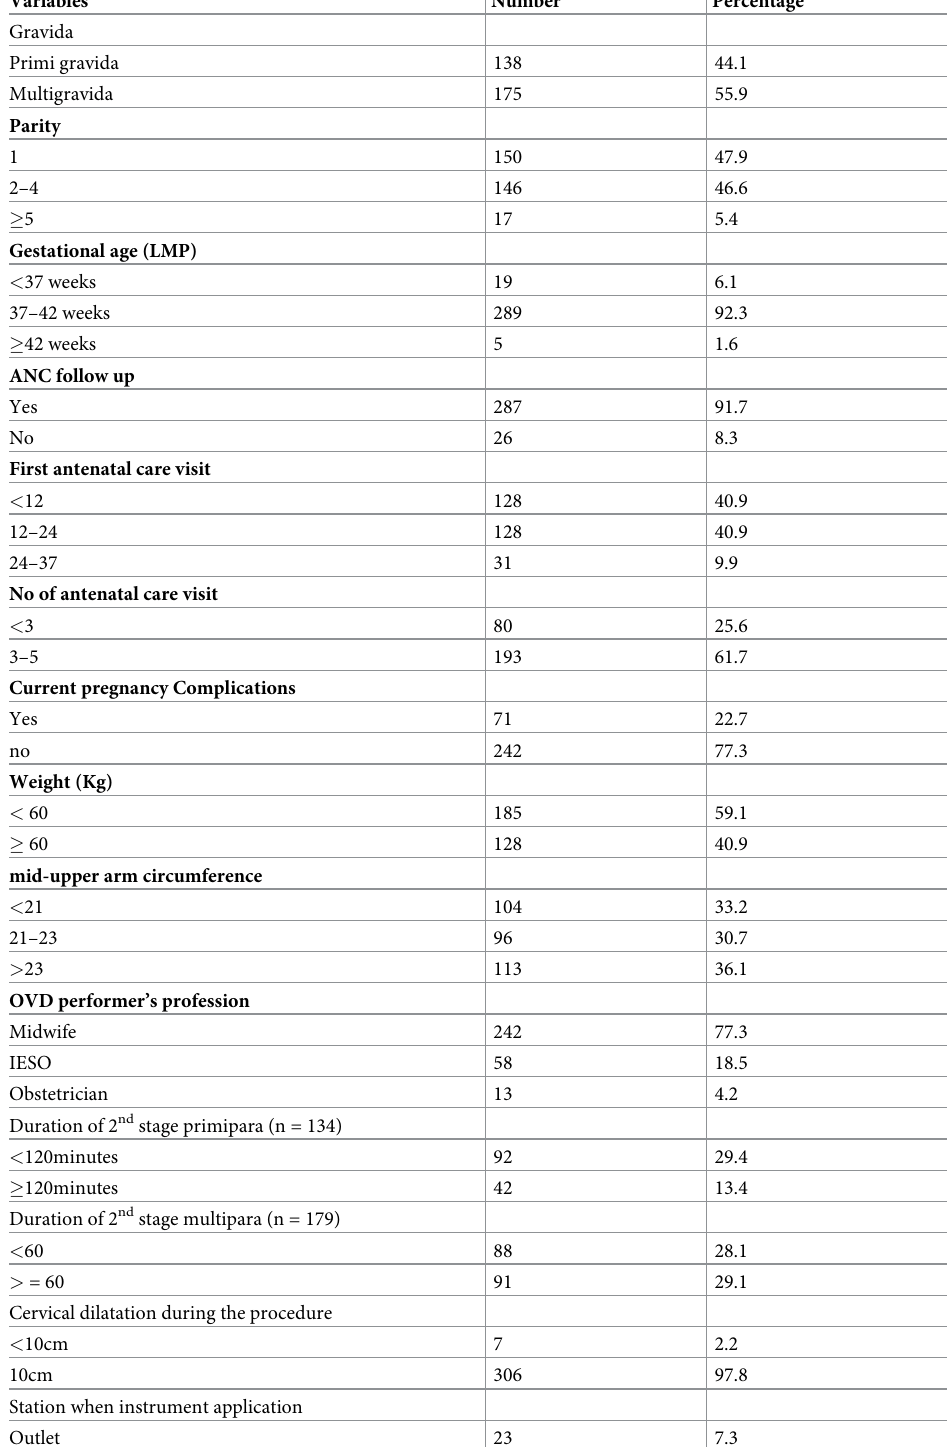
Table 2. Obstetric and related characteristics of operative vaginal delivered mothers in East Gojjam Zone Hospi- tals, Northwest Ethiopia,